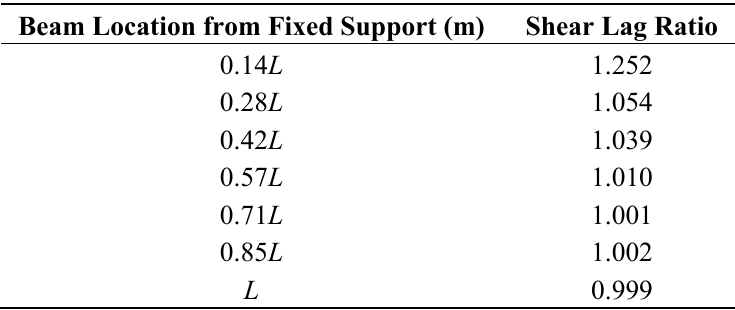
Table 1. Shear lag ratio in